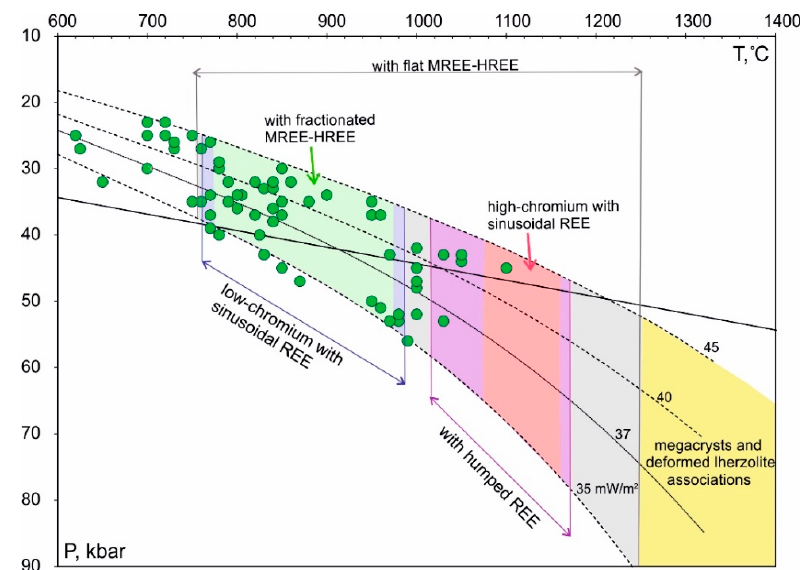
Figure 5. The extrapolation of pyrope T Ni [9] data to the Cr-diopside-derived (green circles) geotherms [2]. Geotherms from [22].